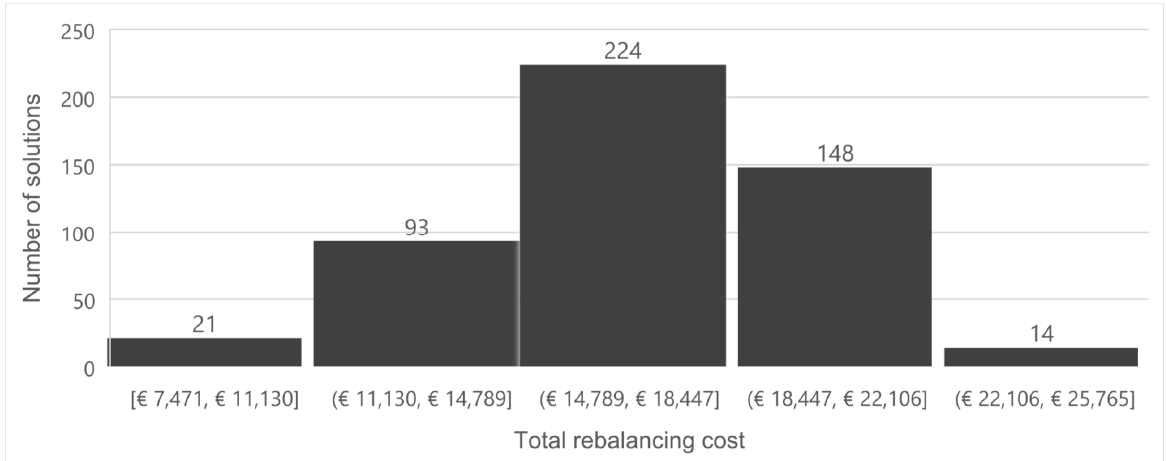
Fig.4 The distribution of the feasible solutions in terms of total rebalancing